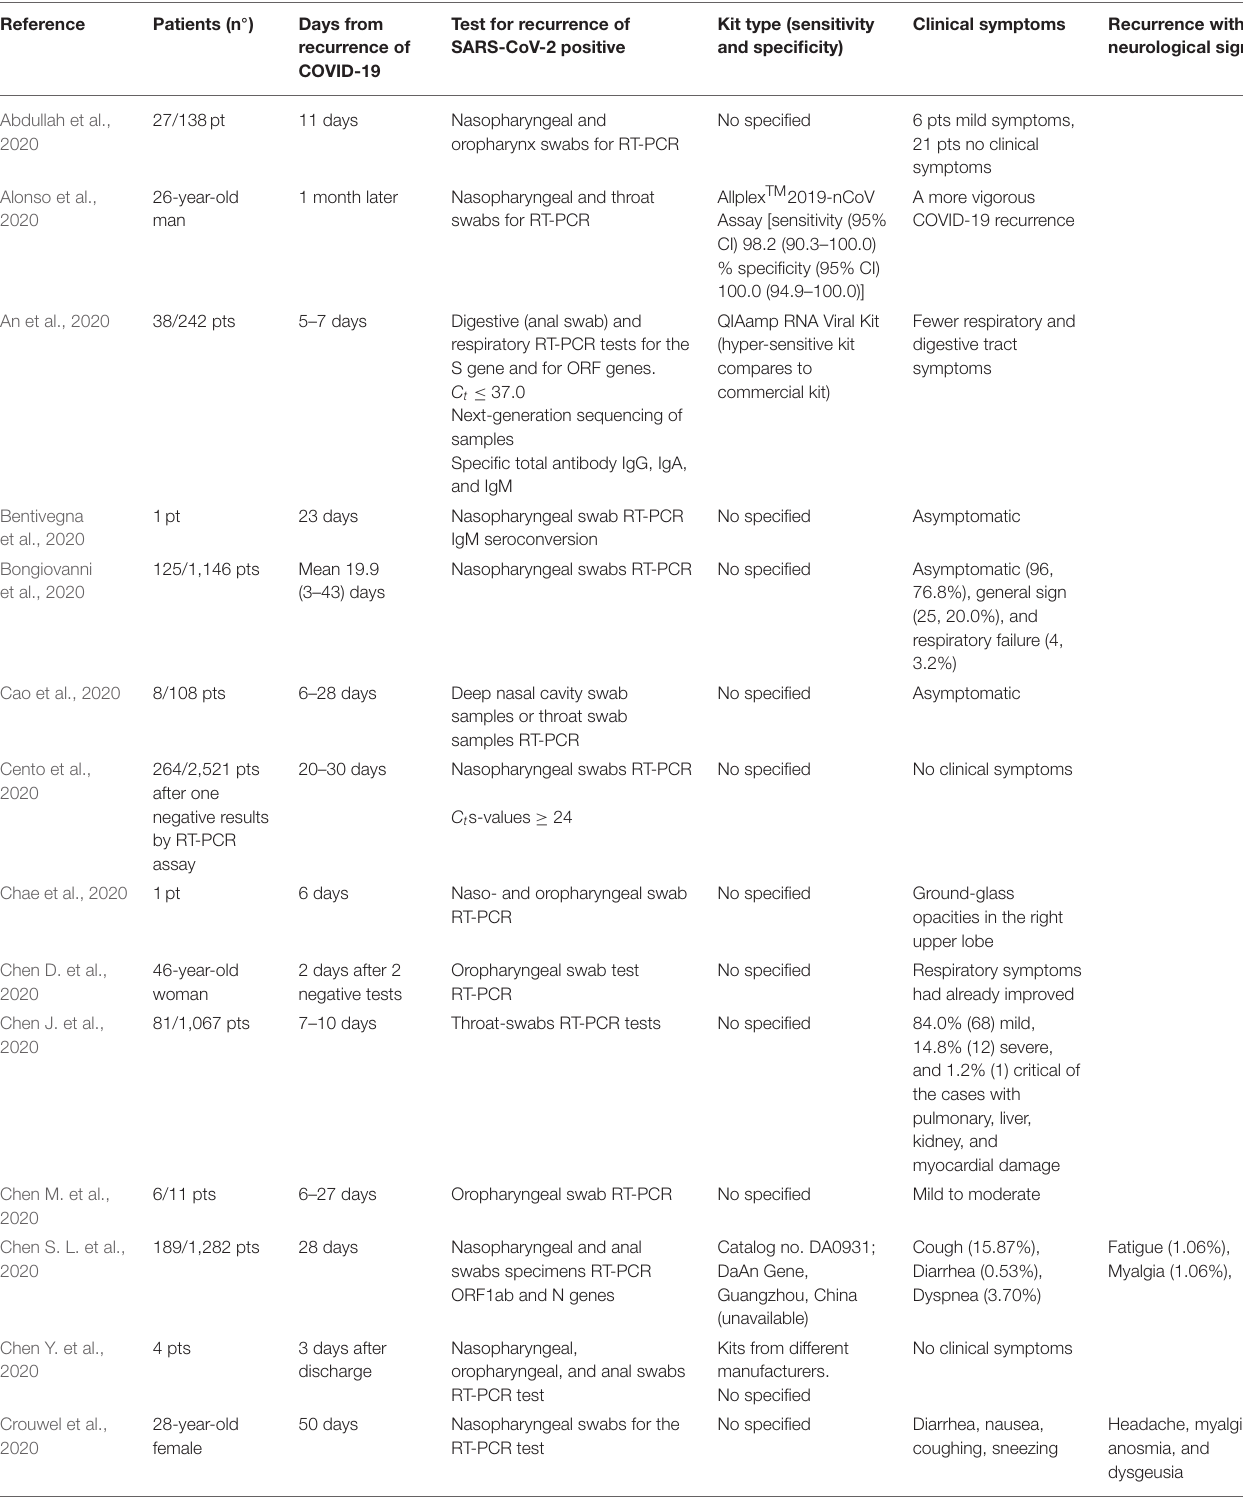
TABLE 1 | Recurrent cases reported in